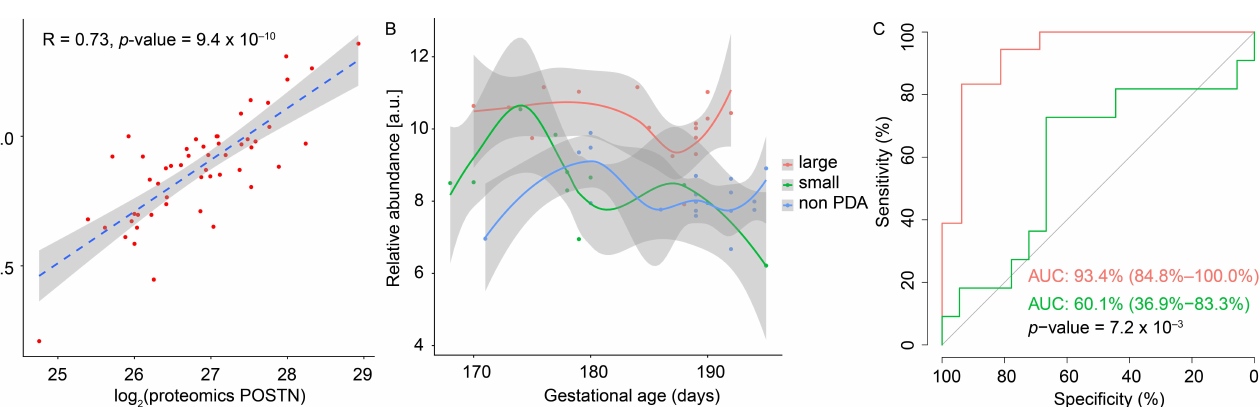
Figure 3. LC-MS proteomics and immunoassay data validation. ( A ) Correlation of periostin (POSTN) plasma levels in all samples as determined by LC-MS and immunoassay. Pearson’s cor- relation coefficient (R), p -value, and 95% confidence interval (grey) is provided. ( B ) NT-proBNP plasma abundance variation over the gestational ages. ( C ) Sensitivity and specificity of NT-proBNP to identify large PDA (red) and small (green) PDA compared to no PDA, respectively. Area under the curve (AUC) and p -value for differences between the ROCs are